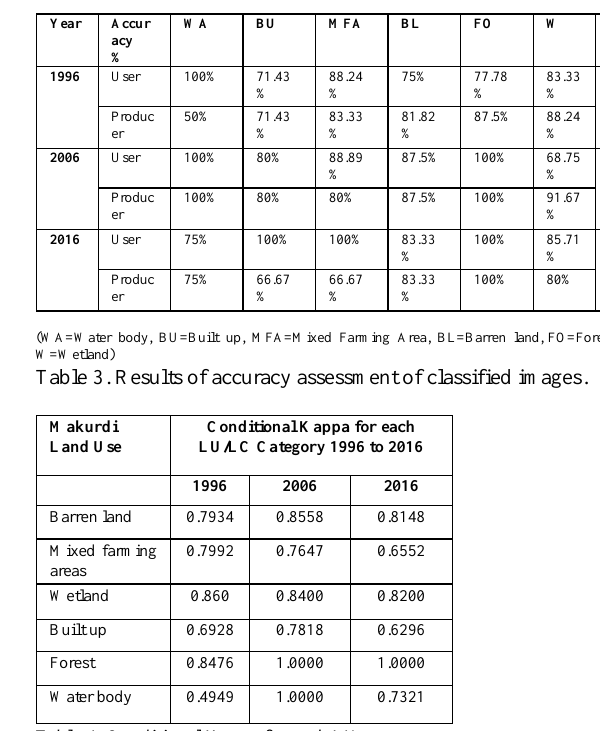
Table 4. Conditional Kappa for each LU